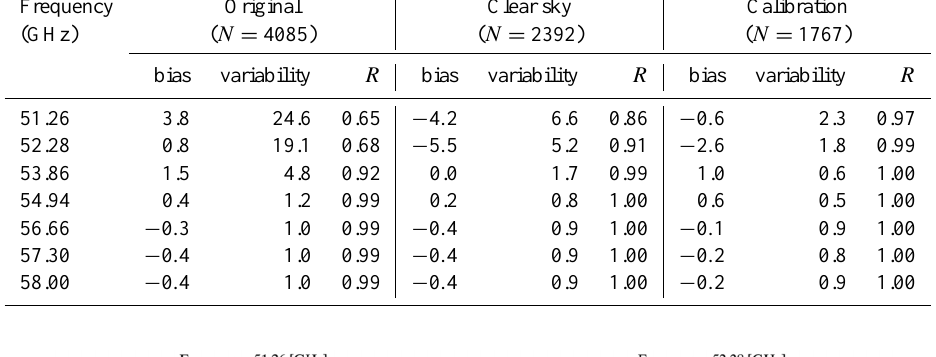
and T M obtained from the data set without any screening process (original), after b b